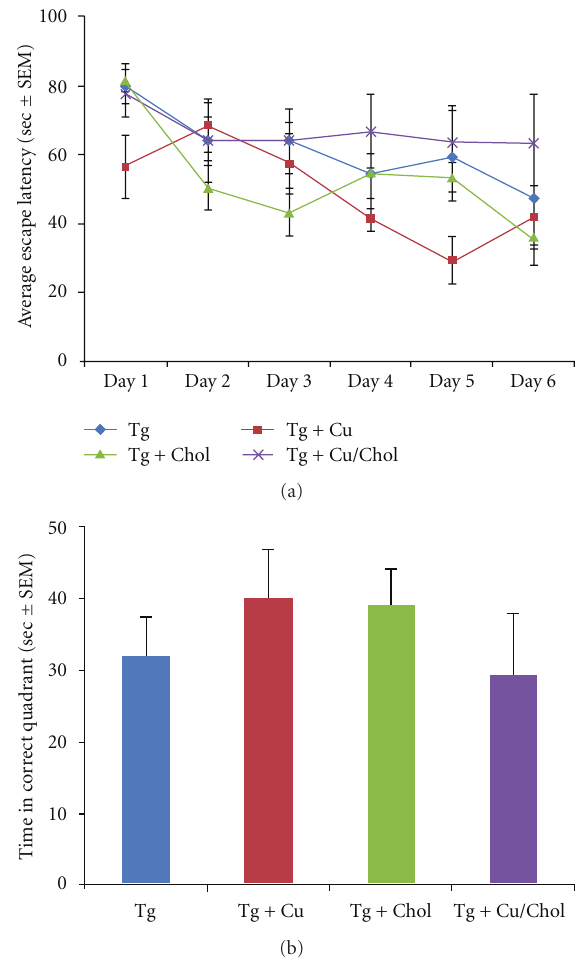
Figure 3: Assessment of spatial learning and memory in APP/PS1 mice in the Morris water maze. There is an overall trend for a modulation of learning performance (a) on this task across the various treatment groups. There was no significant e ff ect on recall in the probe trial across the di ff erent treatment groups